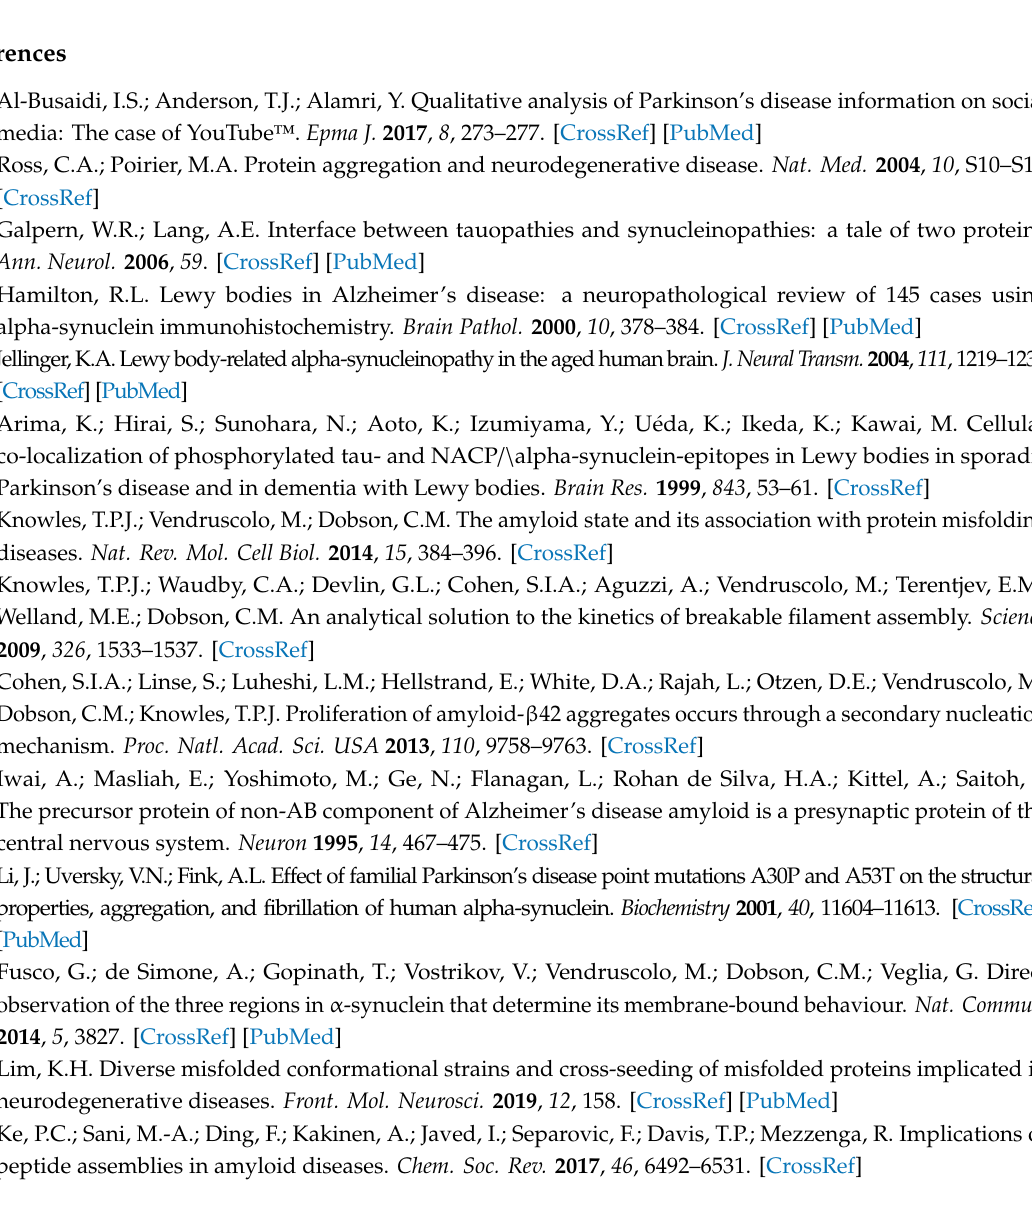
Supplementary Materials: The following figures are available online: Figure S1: Aggregation kinetics of His6- α -synuclein and wt- α -synuclein.; Figure S2: Evaluation of the aggregation rate k of His6- α -synuclein and wt- α